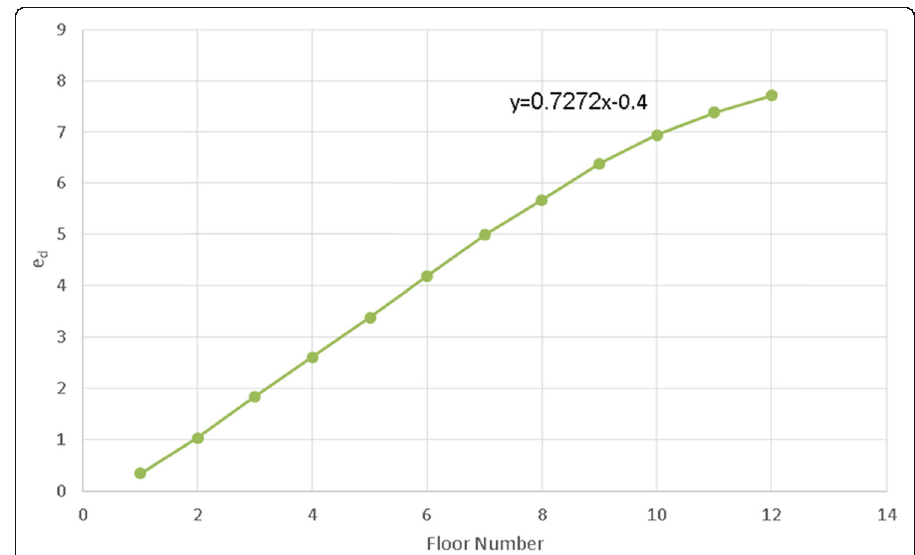
Fig. 40 P.G.A. — e d